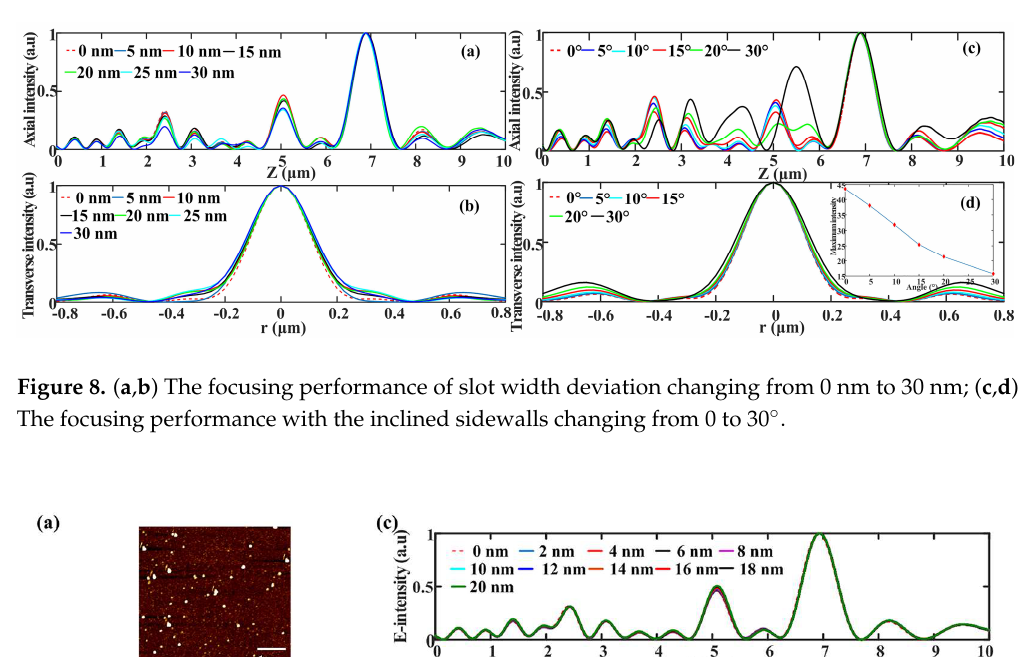
Figure 7. The fitted AFM cross-sectional diagram of the three SOLs with different focal lengths: ( a ) f